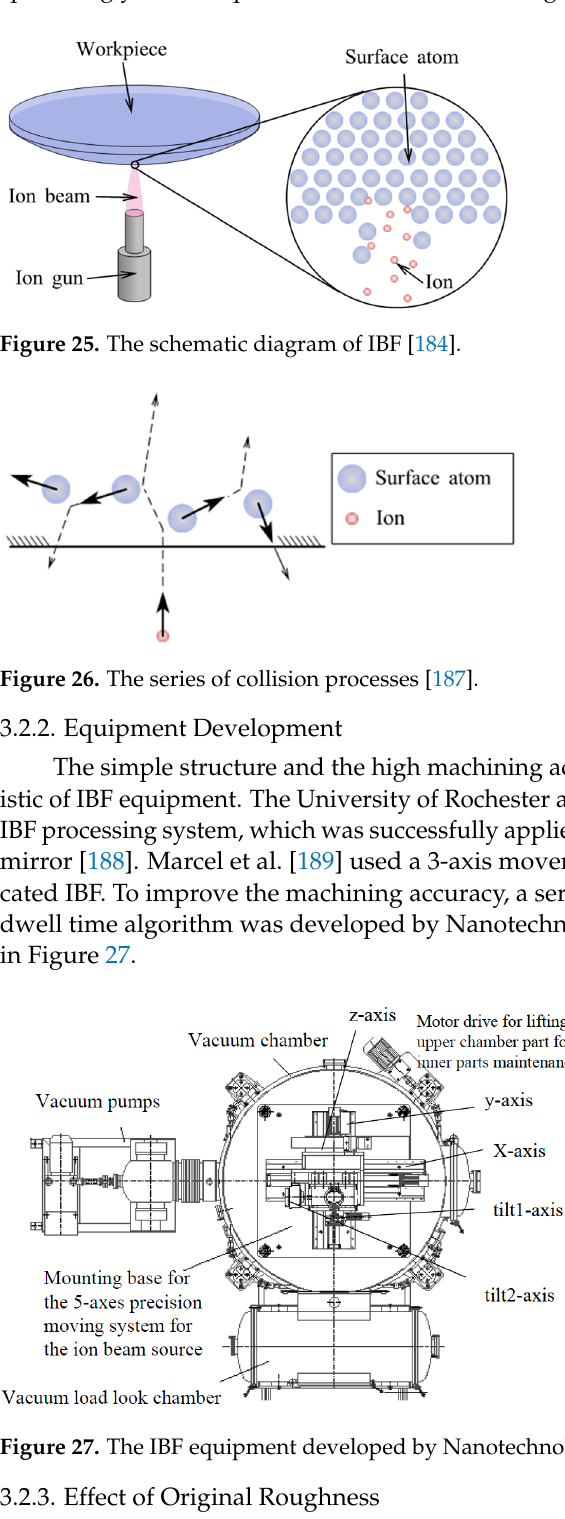
Figure 25. The schematic diagram of IBF [184].